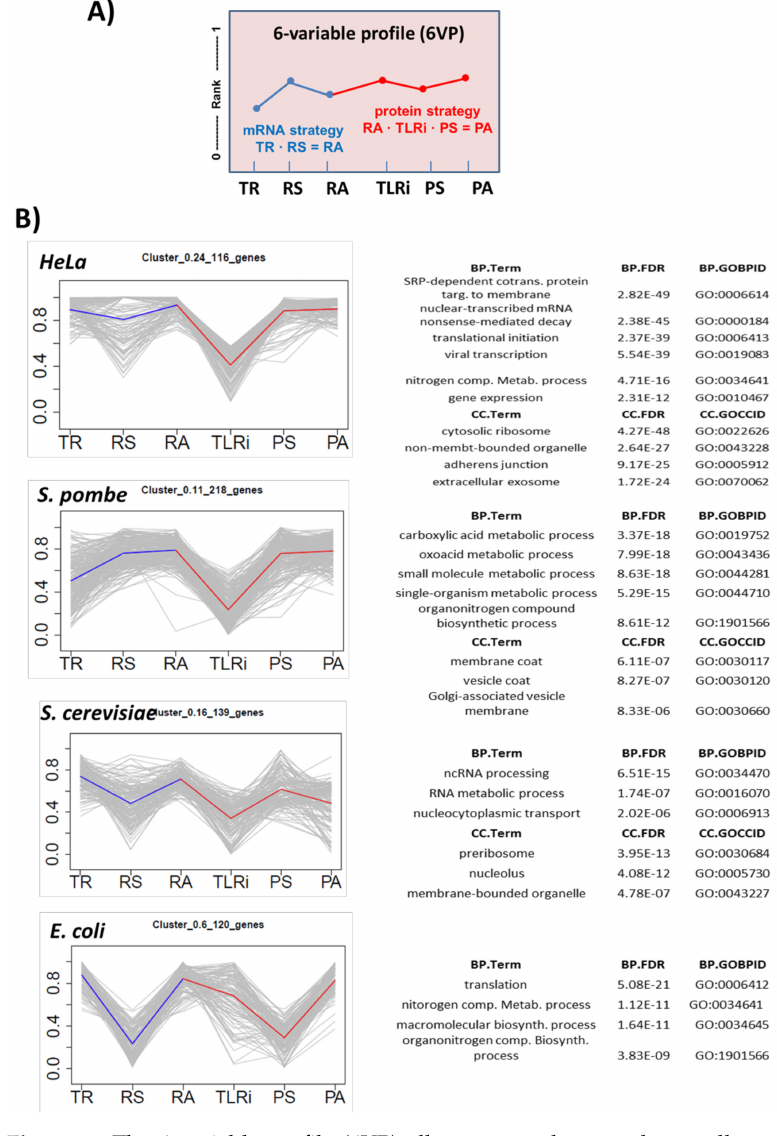
Figure 3. The 6-variable profile (6VP) allows researchers to cluster all genes according to their expression strategy. ( A ) Genes were ranked from lowest (0) to highest (1) in each variable (TR, RS, RA, TLRi, PS, PA). The shape of the line linking the six points is characteristic of an expression strategy: a 6VP. The strategy to gain a defined RA corresponds to the first part of the line (in blue): in the steady state the mRNA level depends on both its transcription rate and stability. For the protein strategy (in red), the final level depends on both the total translation rate (TLRi x RA) and protein stability. ( B ) Many clusters selected from the four studied organisms show defined profiles and statistically enriched GO terms. The individual gene profiles are shown in gray and the average profile of the cluster on the colored line. Some of the GOs with the highest p -values are shown on the right for the Biological Process (BP) and Cellular Component (CC) ontologies. Other examples are found in Supplementary Figure S1 and the whole lists are given as